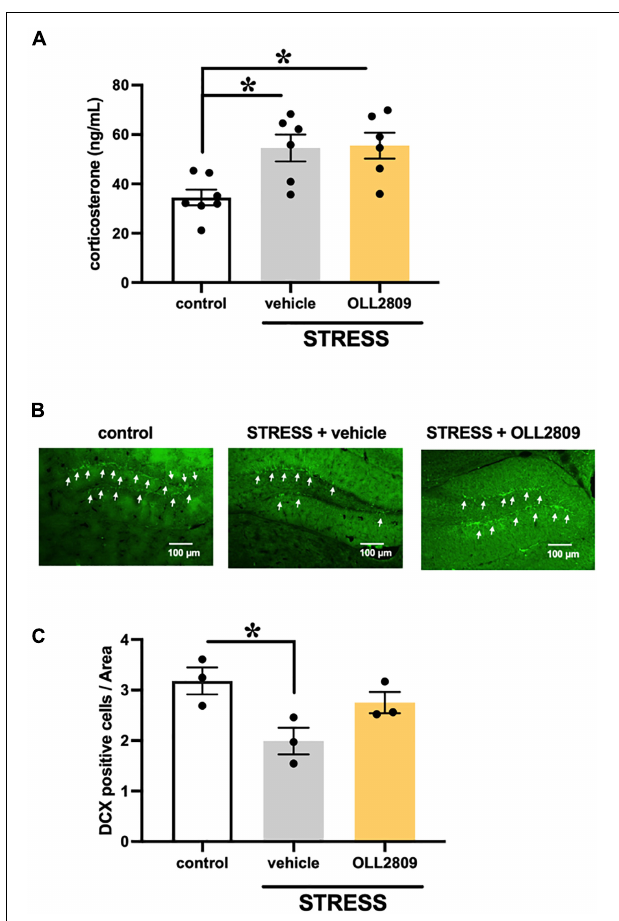
FIGURE 2 | Effects of Lactobacillus paragasseri OLL2809 on serum corticosterone levels and cell proliferation in the hippocampal dentate gyrus. (A) Serum corticosterone levels. Control, n = 7; stress + vehicle, n = 6; stress + OLL2809, n = 6. (B) Photomicrographs of the dentate gyrus showing representative doublecortin (DCX) immunostaining. The scale bar indicates 100 µ m. (C) The density of the DCX-positive area. Control, n = 3; stress + vehicle, n = 3; stress + OLL2809, n = 3. Each bar indicates the mean ± S.E.M. * p < 0.05, Tukey–Kramer test. Each plot represents the number of